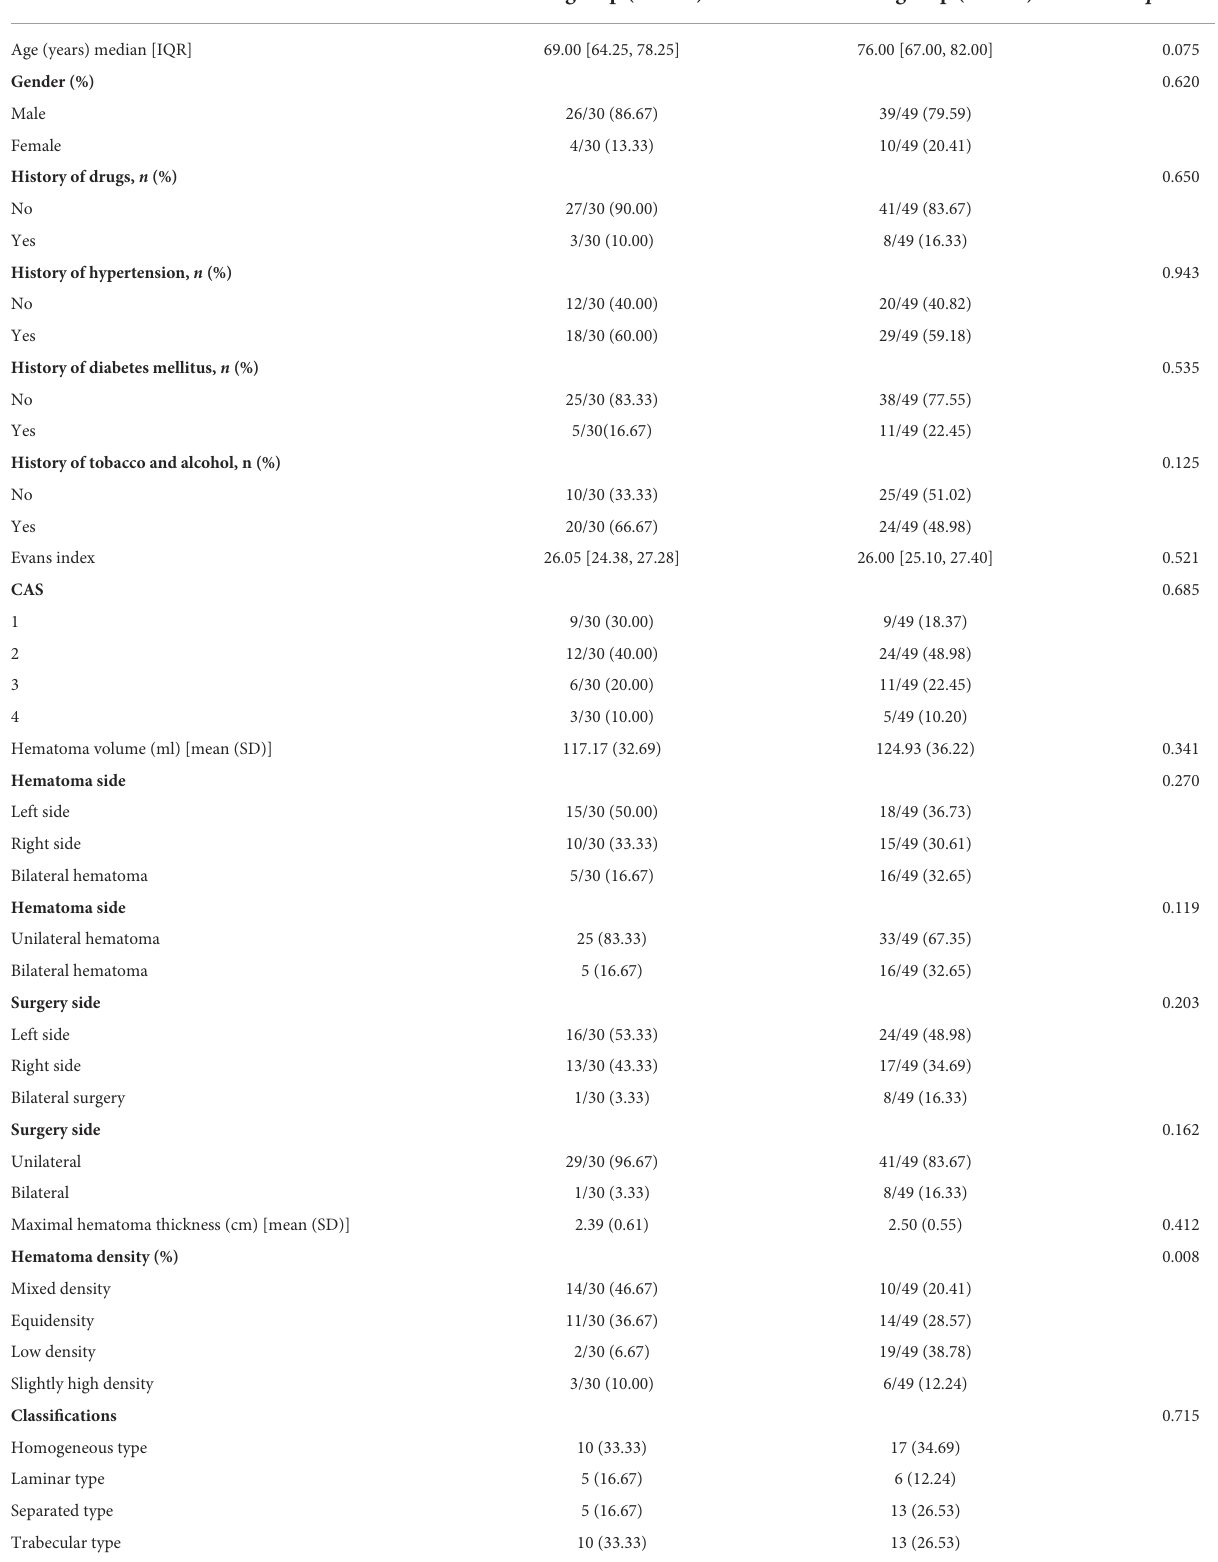
TABLE 1 Baseline characteristics between the test group and control